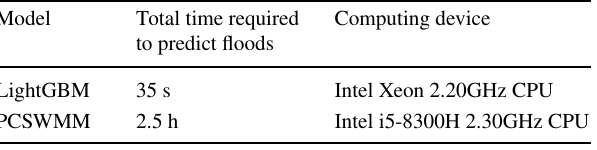
Table 6 The runtimes of the light gradient boosting machine (Light- GBM) and personal computer storm water management model (PCSWMM) models for predicting water depth Model